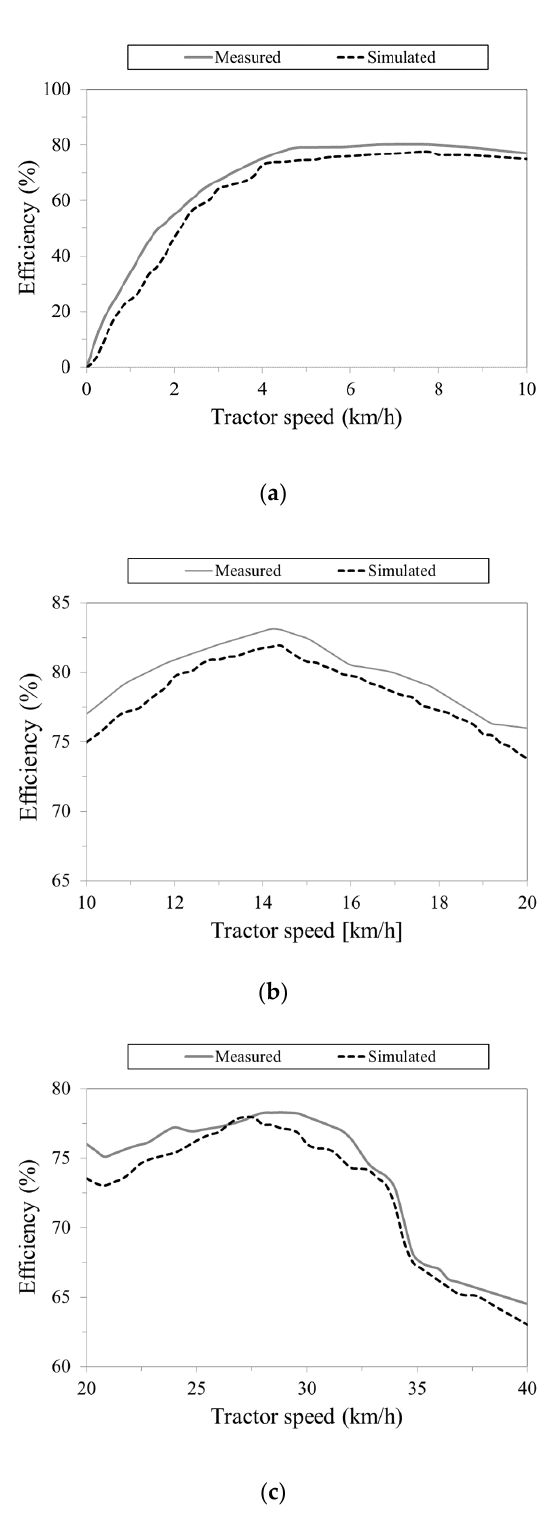
Figure 9. Comparison of the power transmission efficiency of the HMT for the measured and simulated results according to the gear stages: ( a ) first gear stage; ( b ) second gear stage; ( c ) third gear stage.